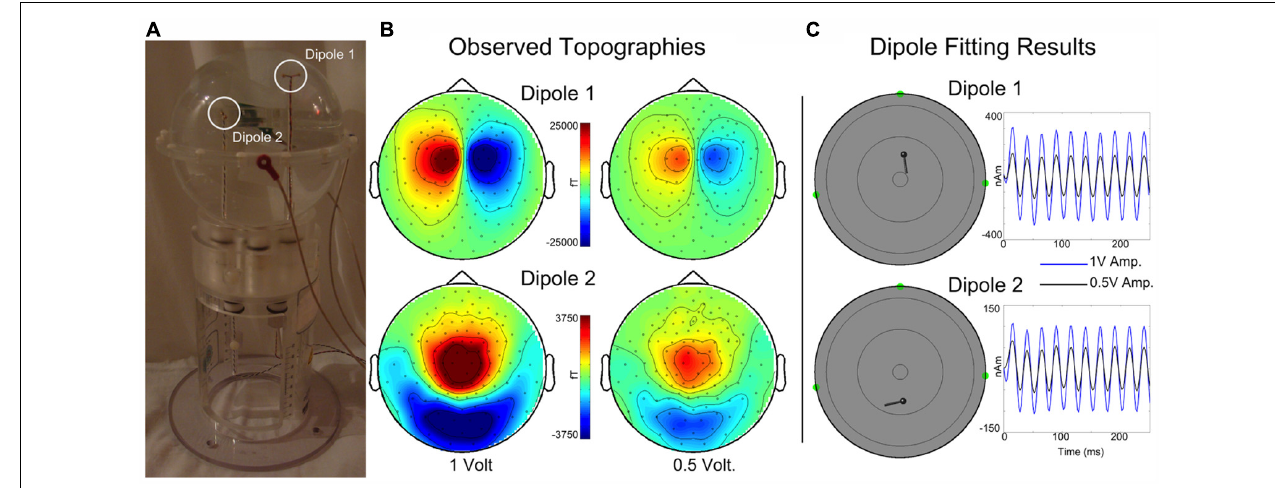
FIGURE 4 | (A) A custom spherical saline-filled phantom with two dipole locations indicated with white circles. (B) Observed topographies for activated Dipoles 1 and 2 are shown for a 40 Hz sinusoidal current source at 1 and 0.5 driving voltages. (C) The corresponding dipole model locations and moment traces for each voltage. Estimated source